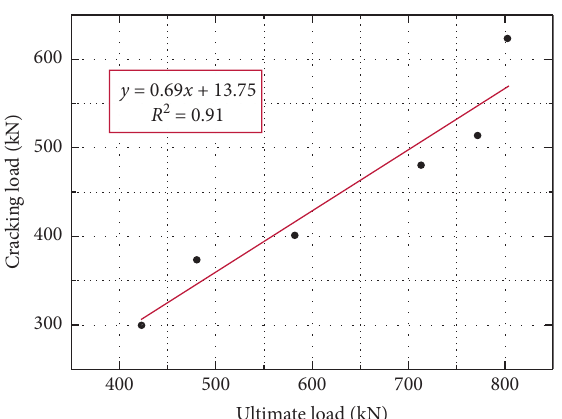
Figure 11: Relations between cracking load and ultimate load of six groups of RCB masonry.